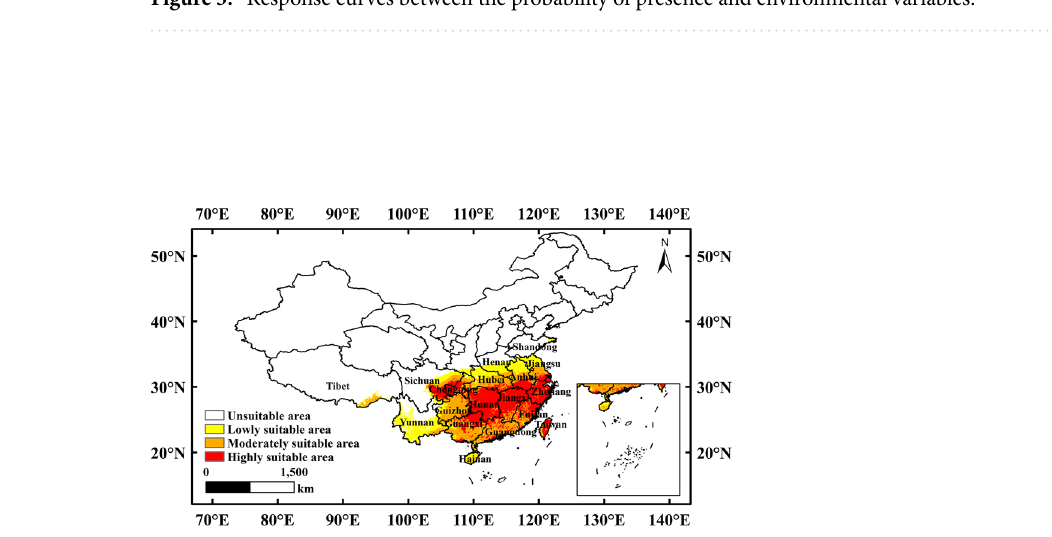
Figure 3. Response curves between the probability of presence and environmental variables.